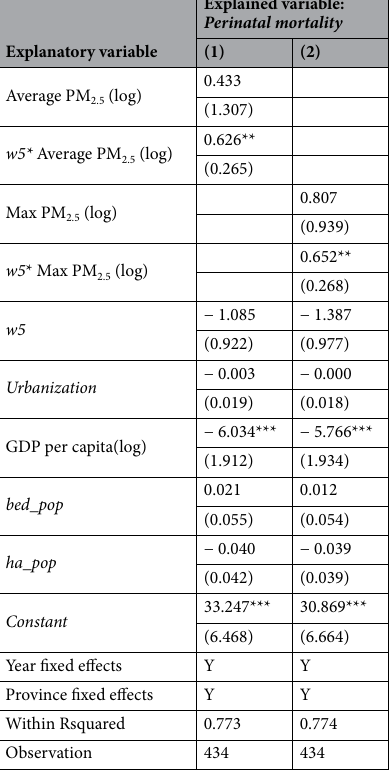
Table 7. Estimated results of mechanism analysis. Standard errors in parentheses. * p < 0.1, ** p < 0.05, *** p <